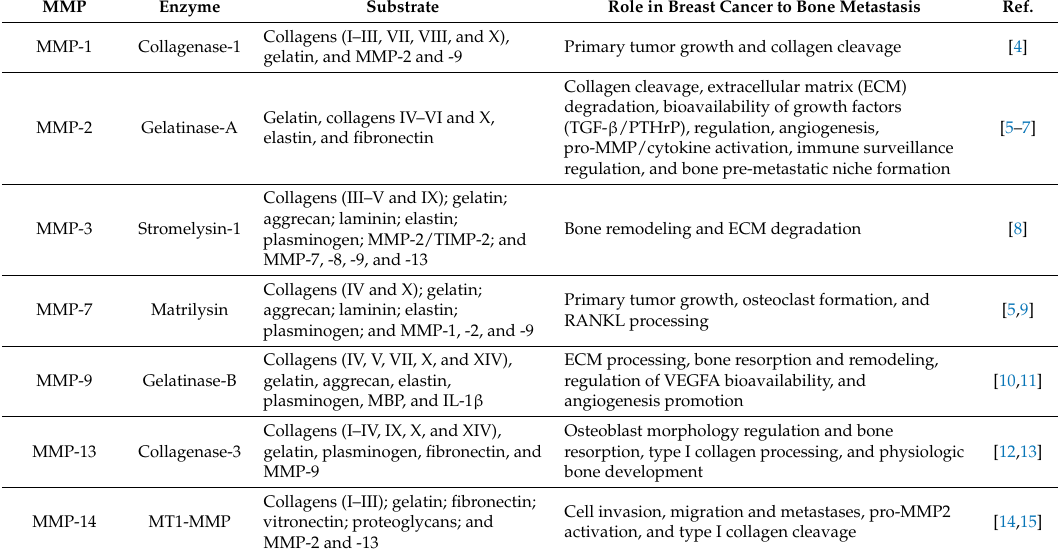
Table 1. Role of matrix metalloproteinases (MMPs) in bone metastatic breast